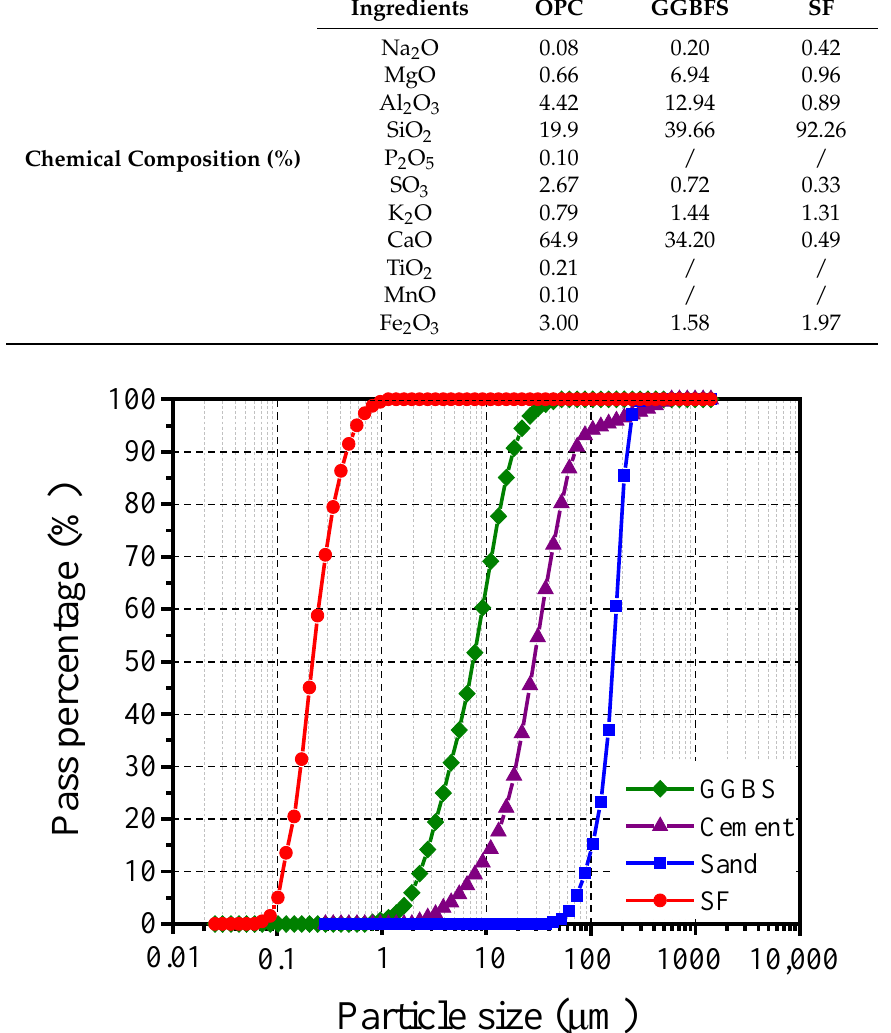
Figure 1. Particle size distributions of the component.